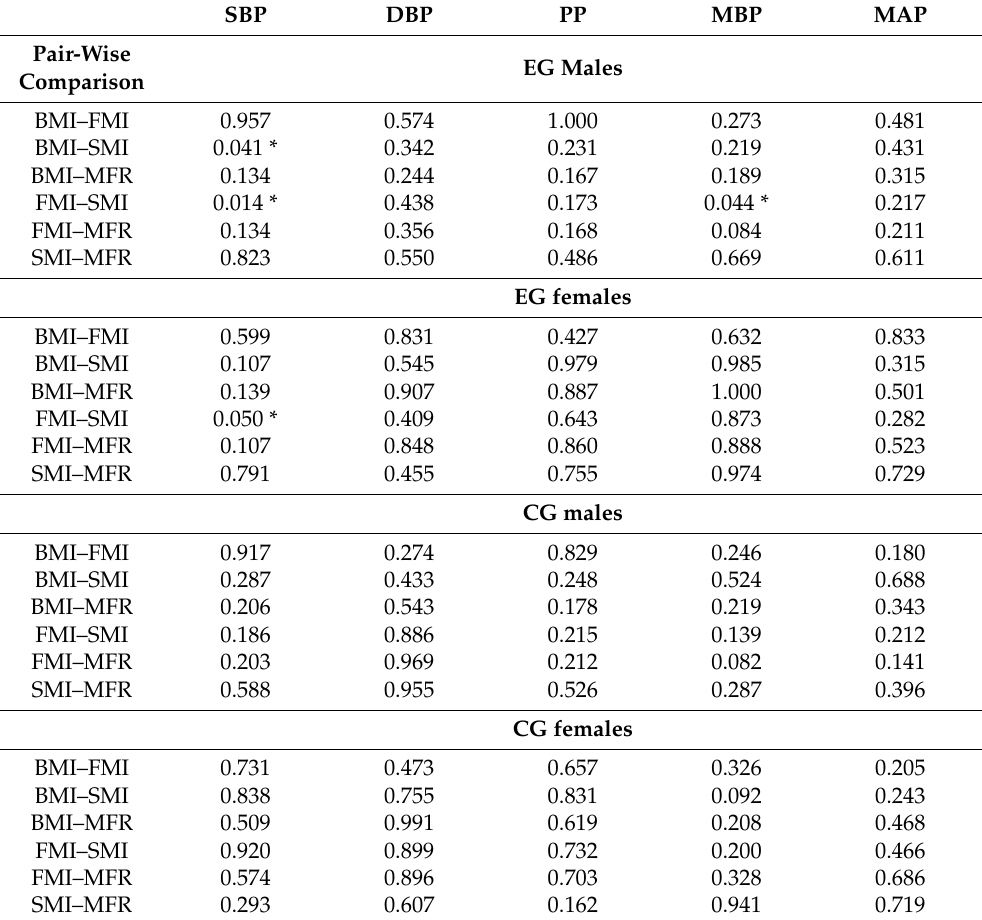
Table 3. Probabilities of the differences between AUC in comparisons between body composition indices per groups of students.